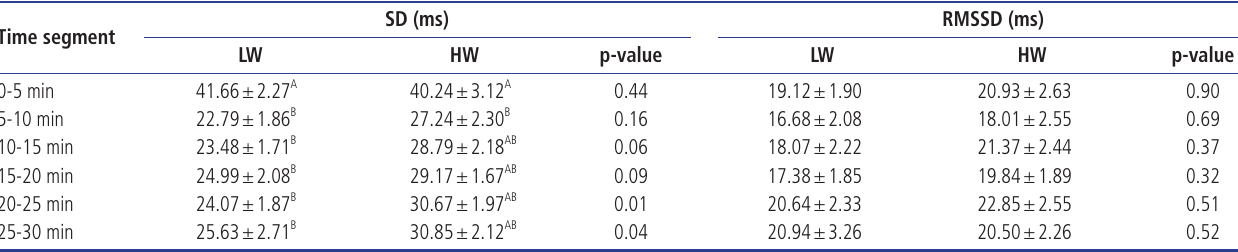
Table 4. Comparison in time-domain indexes between LW and HW groups during isolation test Time segment